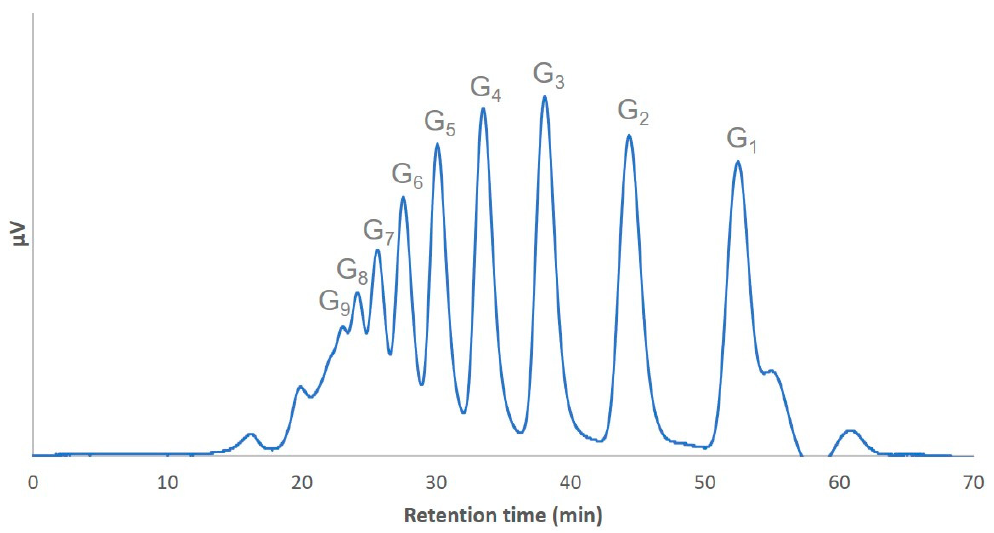
Figure 1. HPLC analysis of α‐ (1 → 3) ‐ glucooligosaccharides obtained by partial acid hydrolysis of Laetiporus sulphureus α‐ (1 → 3) ‐ glucan. In the abbreviation Gn, “n” represents the degree of polymerization.